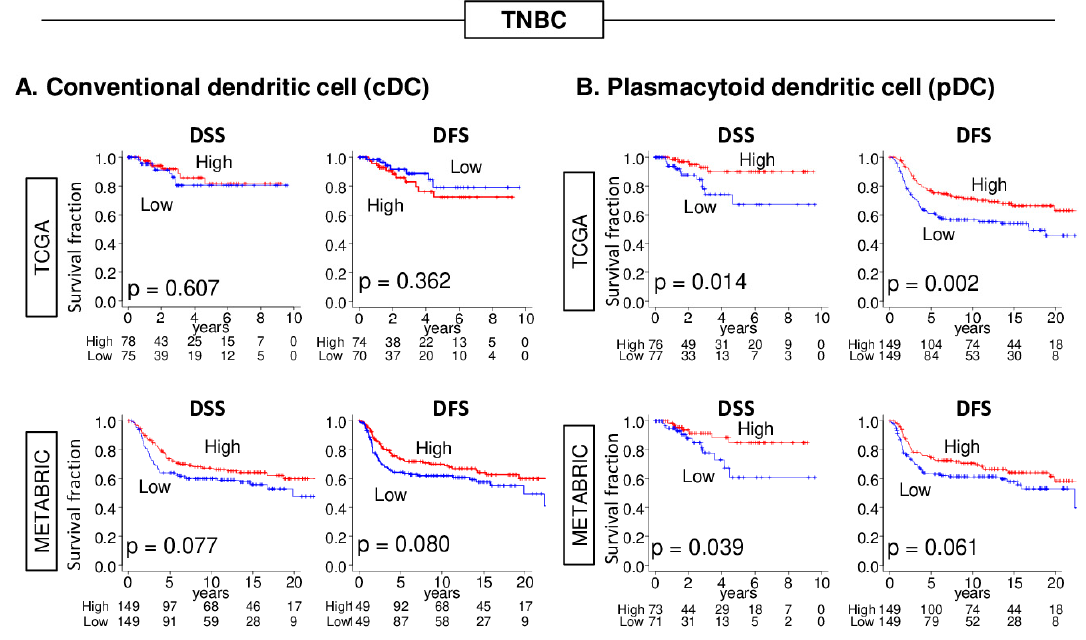
Figure 2. Association between cDCs or pDCs and the survival of triple-negative breast cancer (TNBC) patients in the TCGA and METABRIC cohorts. DFS and DSS of ( A ) cDC and ( B ) pDC in TNBC. Median was used as the cut-off to divide patients into low (blue) and high (red) groups within each cohort. To compare the two groups, Kaplan–Meier curves with the log-rank test was used for survival analysis.